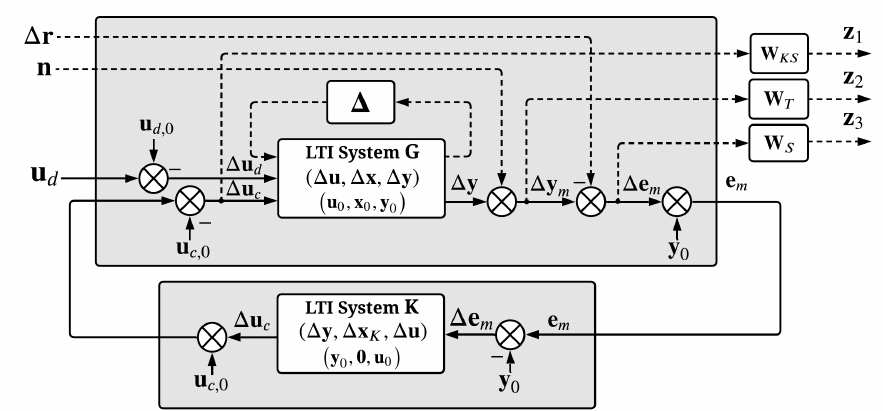
Figure 6. Robust controller synthesis diagram for the plant G , with the uncertainty set ∆ determined a priori using the functionality from Section 2.5, linearized at the operating point ( u 0 , x 0 , y 0 ) ; by convention, control inputs ∆ u c of the linearized plant G are indexed after disturbance inputs ∆ u d